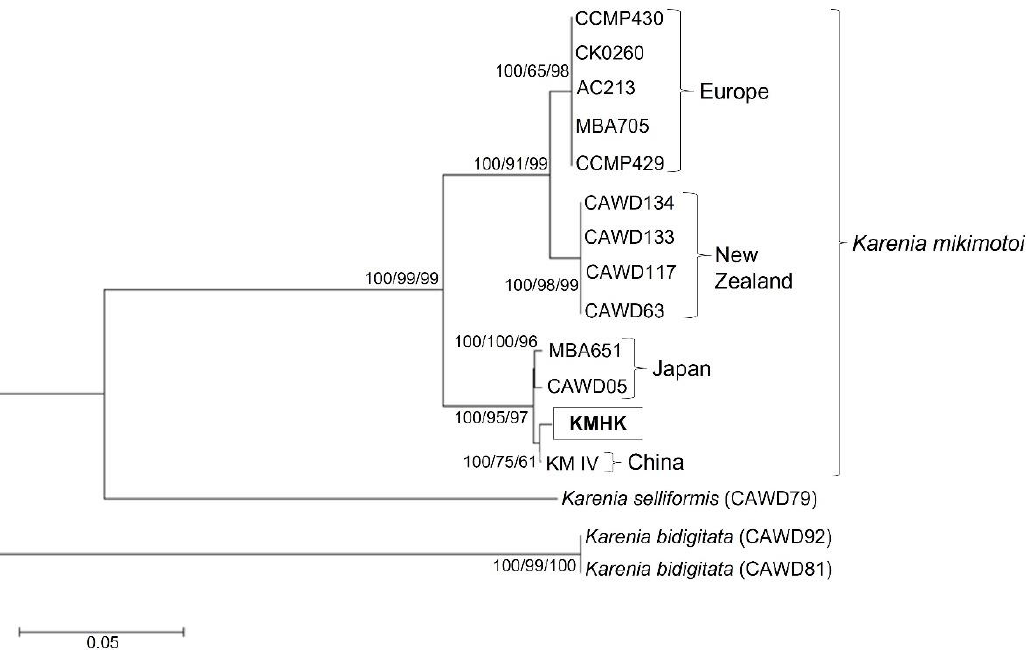
Figure 1. The phylogenetic inference tree based on a distance matrix algorithm between the concatenated sequences from LSU rDNA, ITS1-5.8S-ITS2 and rbc L (Neighbor, in PHYLIP version 3.69). Numbers at nodes (corresponding to LSU rDNA/ITS1-5.8S-ITS2/ rbcL respectively) indicate % based on bootstrap values retrieved from 1000 replicates for the neighbor-joining analyses. Scale bars indicate substitutions per site. Karenia selliformis (CAWD79) and Karenia bidigitata (CAWD92 and CAWD81) were used as outgroups to root the phylogenetic tree. The Hong Kong strain K. mikimotoi (KMHK) is bolded. The accession number for LSU rDNA, ITS1-5.8S-ITS2 and rbcL of KMHK is ON898609, ON898610 and ON937622, respectively.